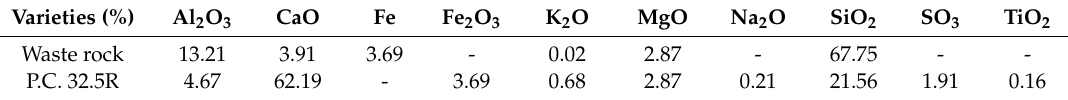
Table 1. The chemical components of waste rock and composite Portland cement 32.5R.